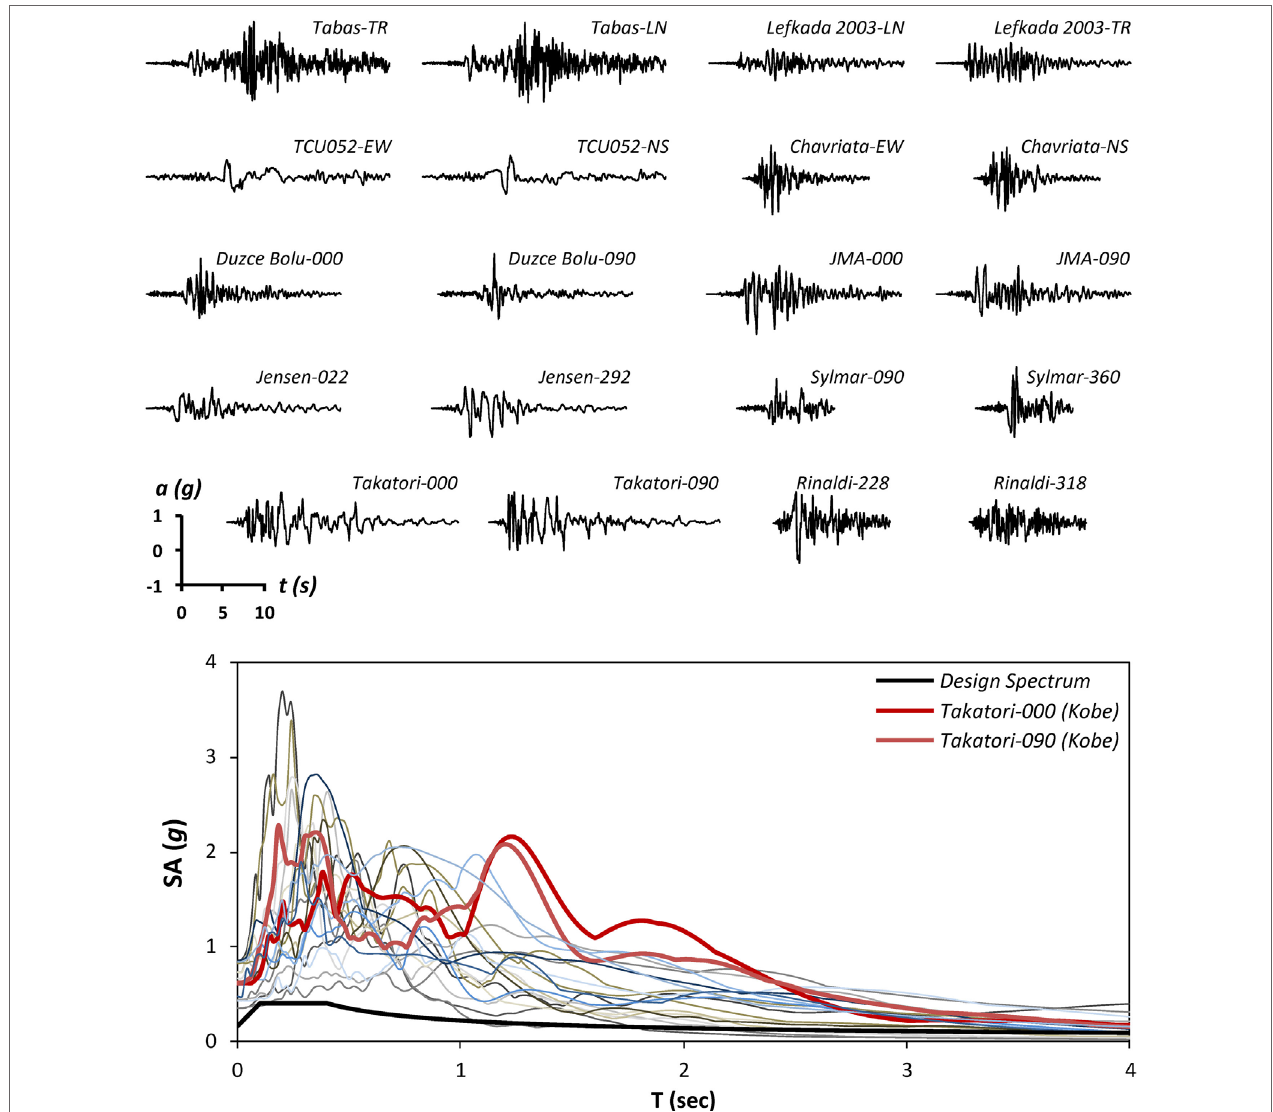
FigUre 8 | Real earthquake records used for the analysis of the three examined bridge systems, along with their elastic spectra and the design spectrum of the investigated bridge. The selected ensemble of 20 records (10 ground motions of 2 perpendicular components each) covers a range of seismic excitations from strong intensity (e.g., Lefkada-2003), to very strong accelerograms characterized by forward-rupture directivity effects, large number of significant cycles, and/or flingstep effects (e.g., Takatori, JMA,